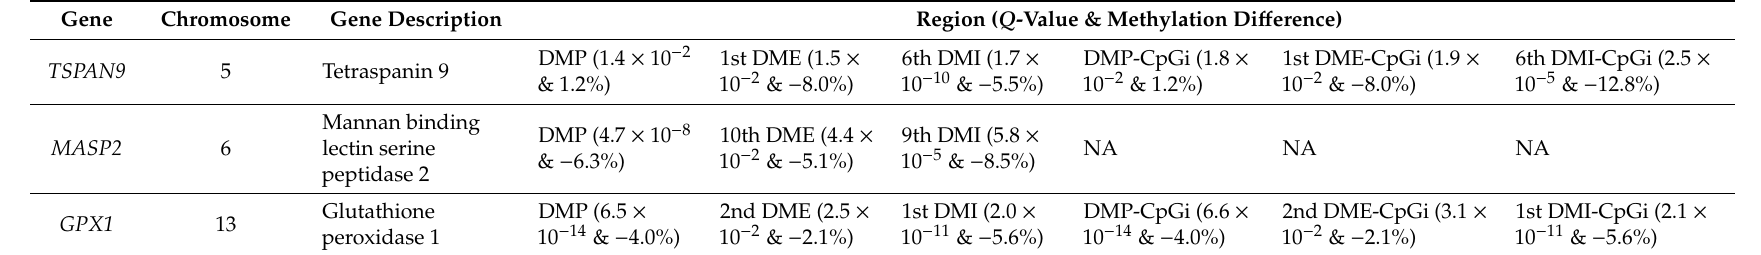
Table 1. Common annotated genes of DMP, DME, DMI, DMP-CpGi, DME-CpGi and